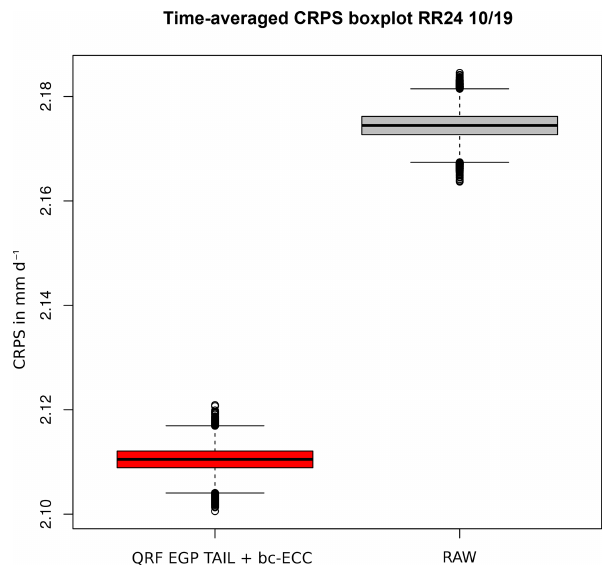
Figure 14. CRPS of daily distributions during October